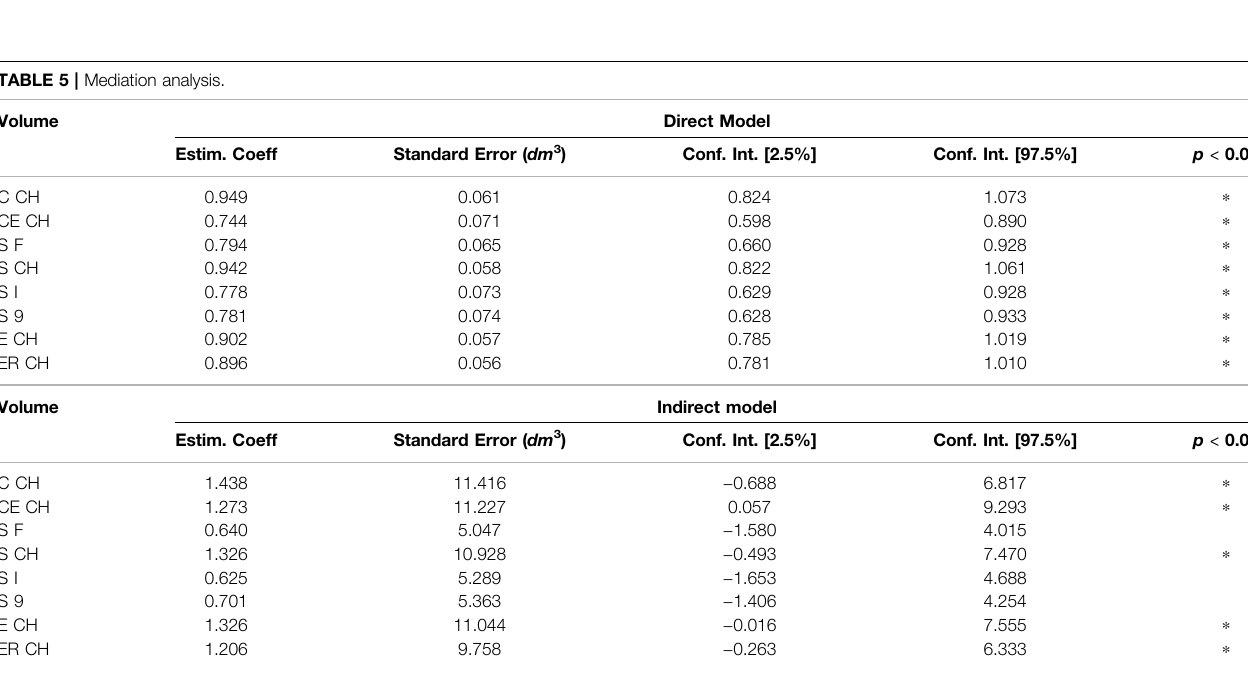
TABLE 5 | Mediation